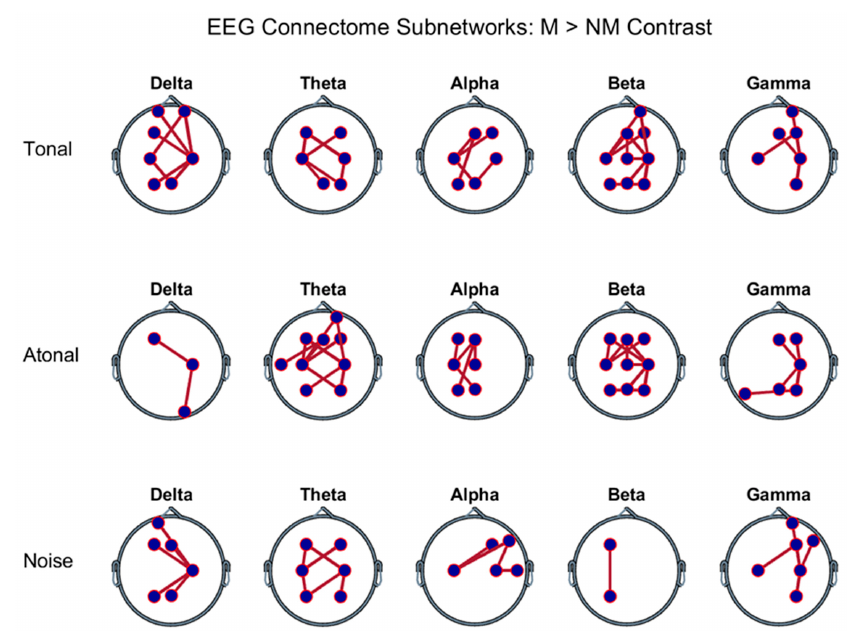
Figure 4. Electroencephalographic ( EEG) connectome’s subnets that were significant (FDR < 0.05) when comparing musicians (M) versus non-musicians (NM). They are plotted in the frequency bands (in columns) and during the auditions indicated in each row on the left. The connections (red lines) between nodes (blue circles) that make up each subnetwork correspond to functional connectivities whose magnitude was higher in the M than in the NM. See subnetworks statistical significance in the text.